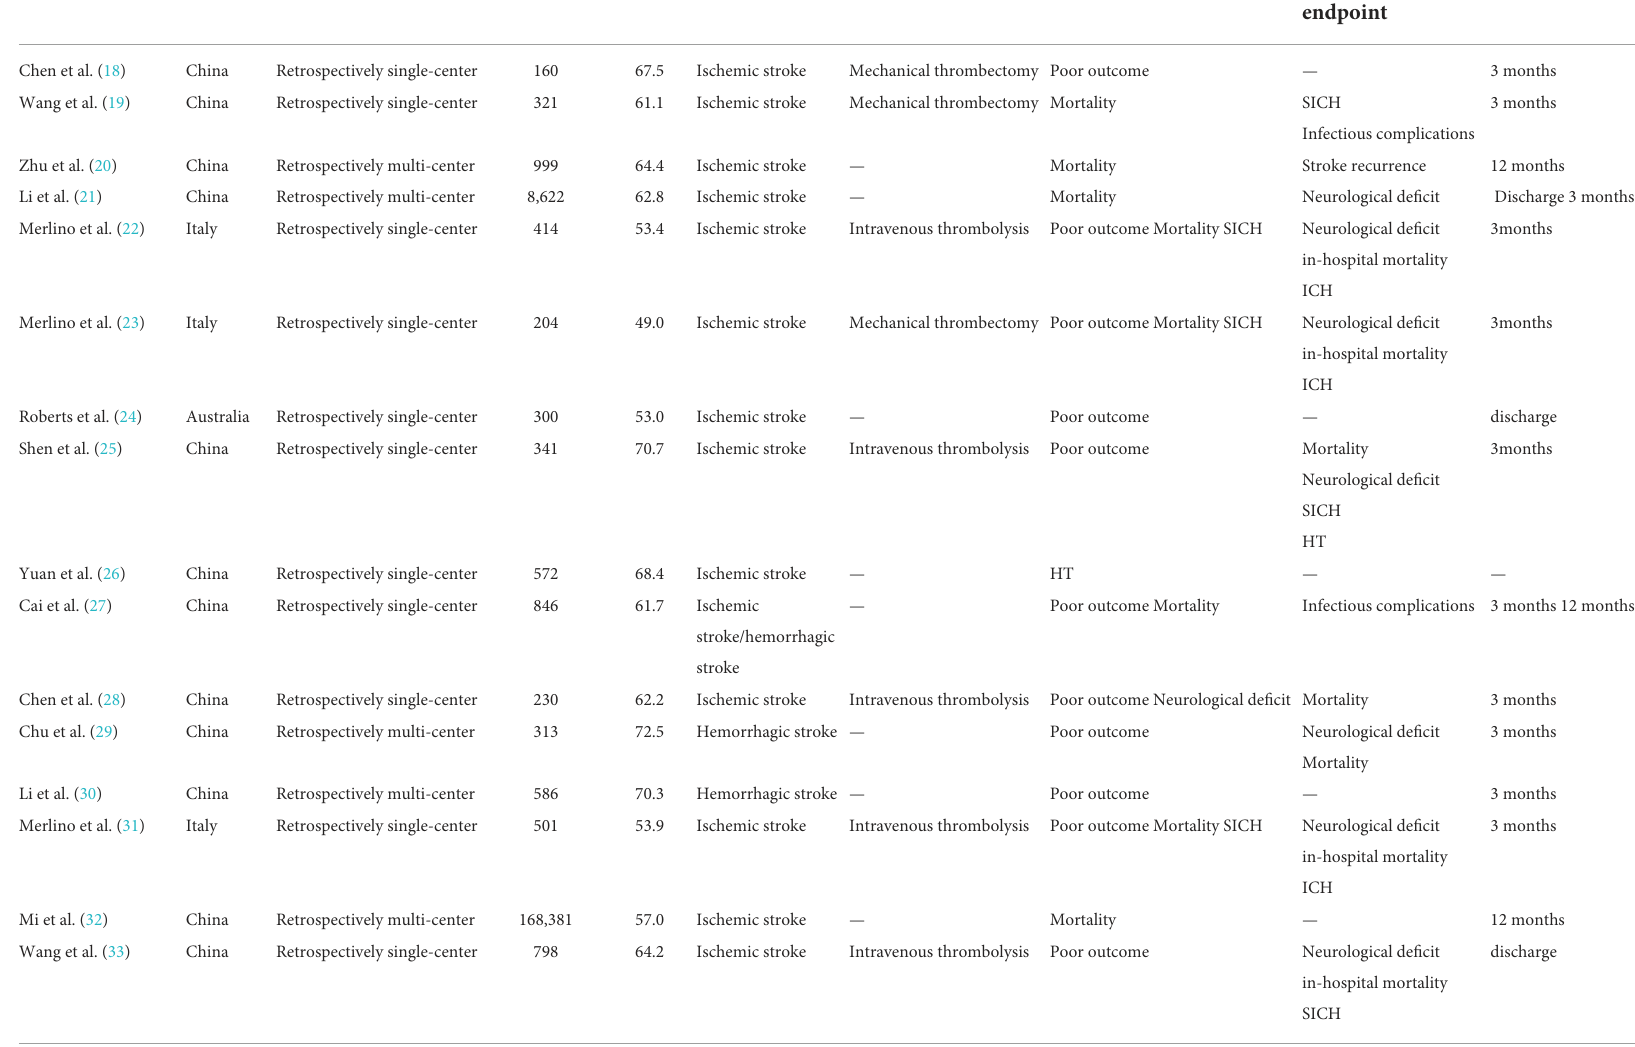
TABLE 1 Baseline characteristic description of the included